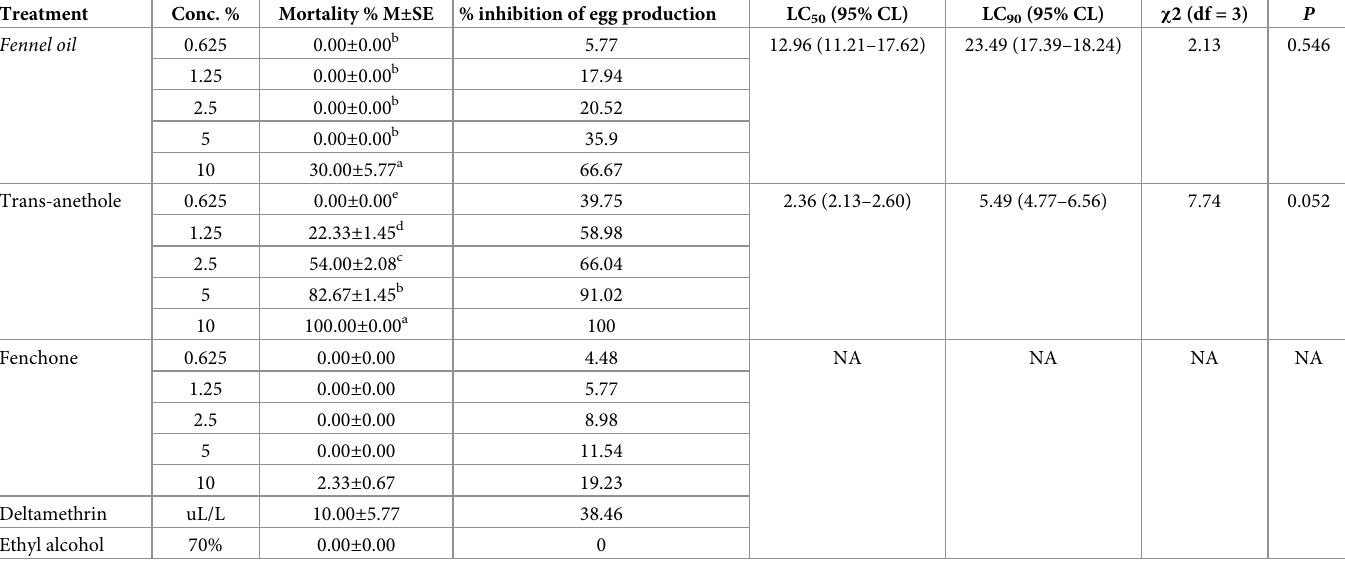
Means within the same column followed by different superscripts are significantly different (Duncan’s multiple range test: P � 0.05). X 2 chi square. (df) degree of freedom. NA = not available.